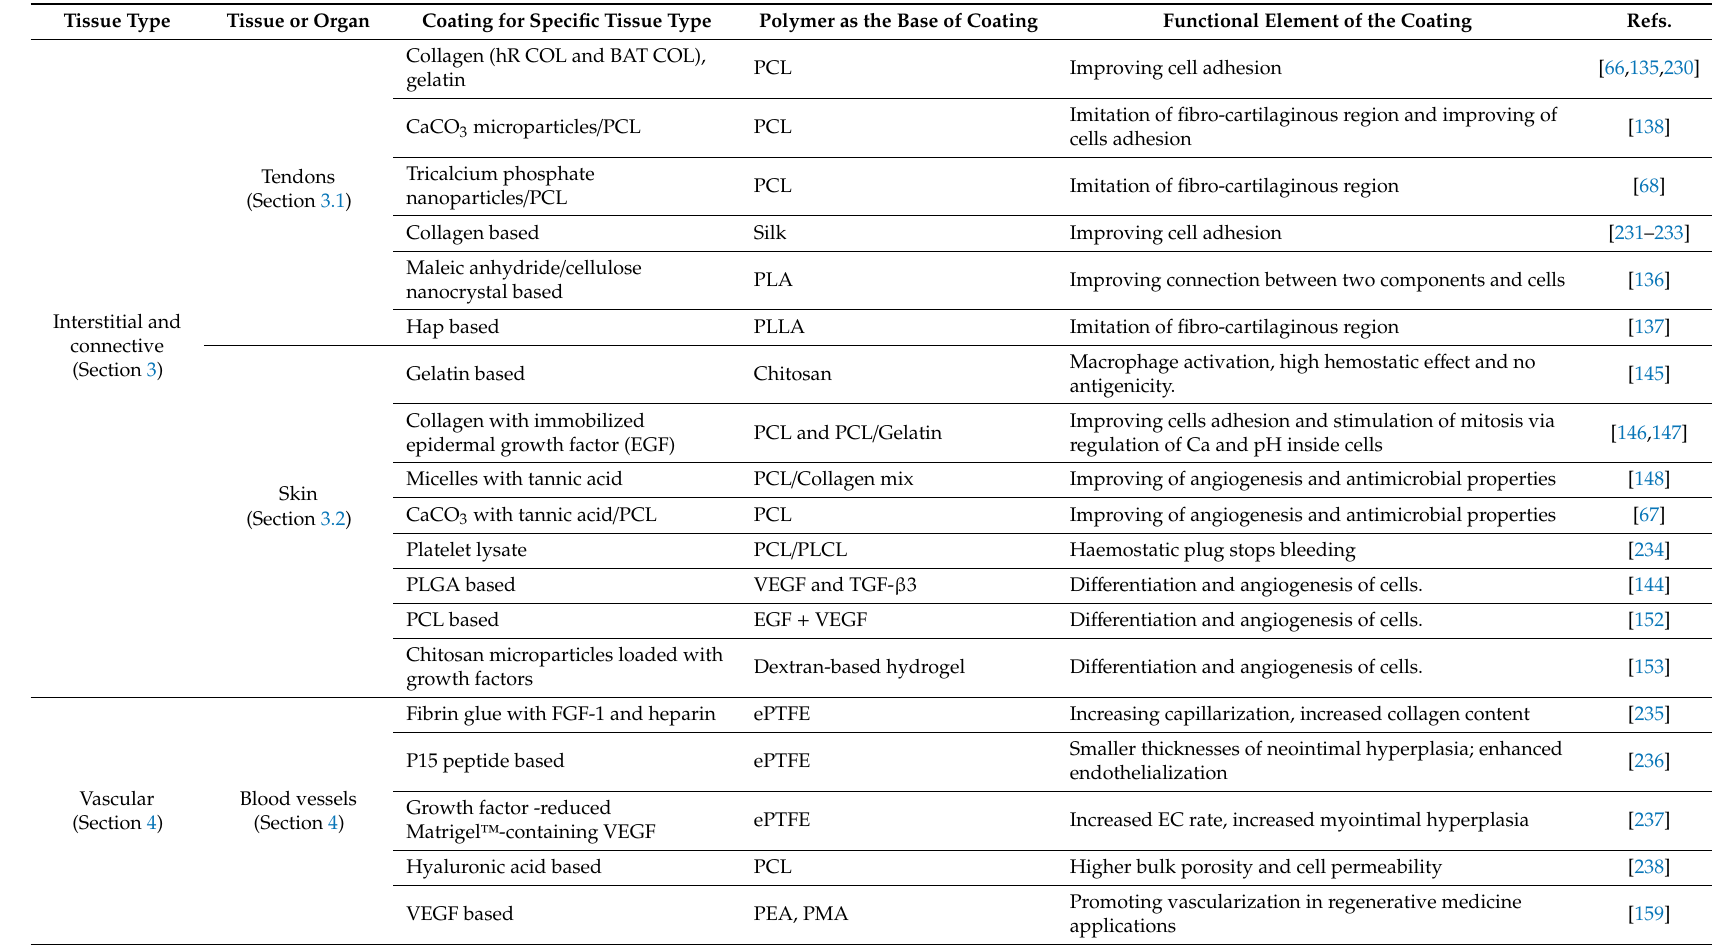
Table 1. Representative examples of polymer-and hybrid-based biomaterials with specific coating for interstitial, connective, vascular, nervous, visceral and musculoskeletal